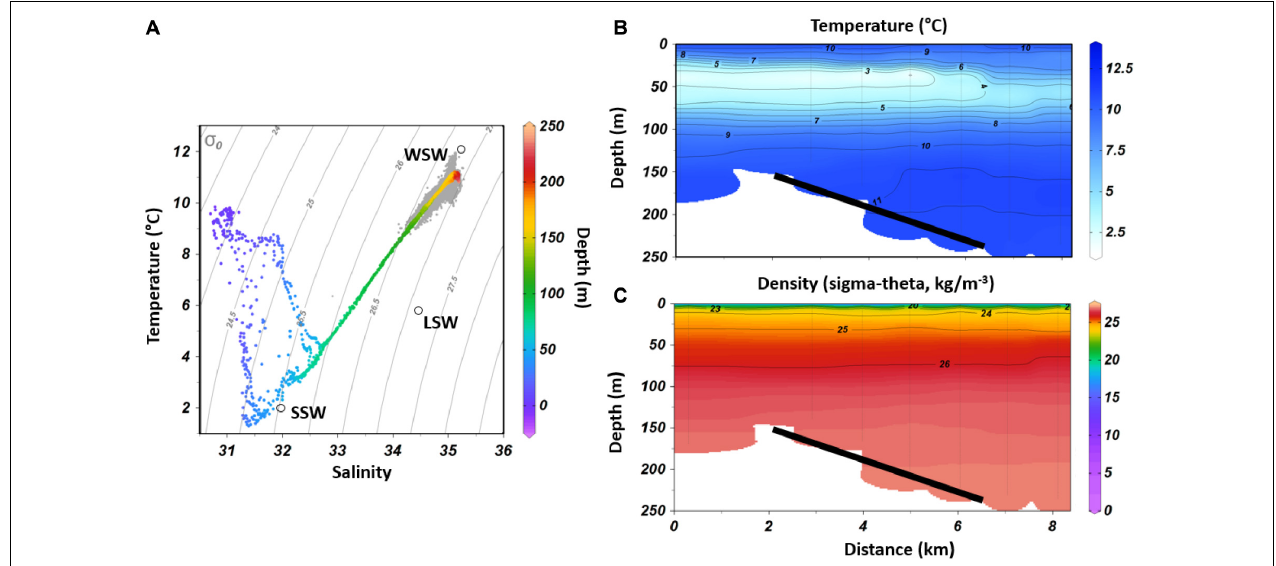
FIGURE 2 | (A) T/S plot of CTD and lander data in gray. The characteristic end members of temperature and salinity for WSW, LSW and SSW are plotted (Mountain, 2012); (B) Temperature transect inside the Sambro Bank closure, with the westernmost station (on the left) located outside of the densest sponge area; (C) Density along the same transect. The black bars indicate the depth distribution of the sponge ground (150–250 m water depth).